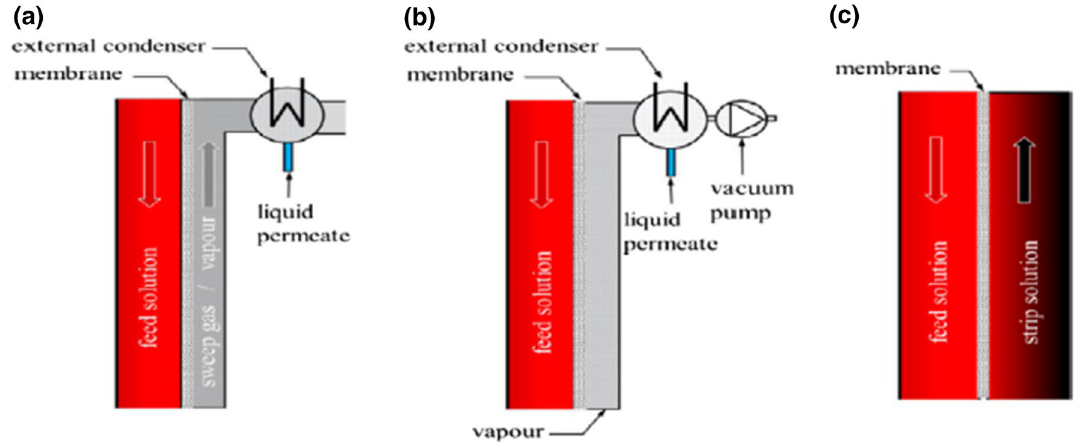
Fig. 4 MD configurations driven by approaches other than a temperature difference: a SGMD, b VMD, and c